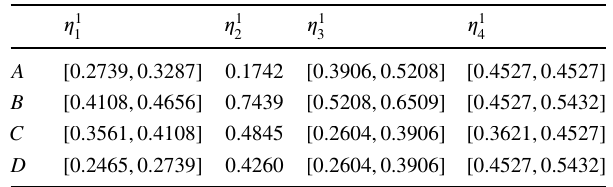
𝛽 1 under the ele- ij 4 × 3 ( )